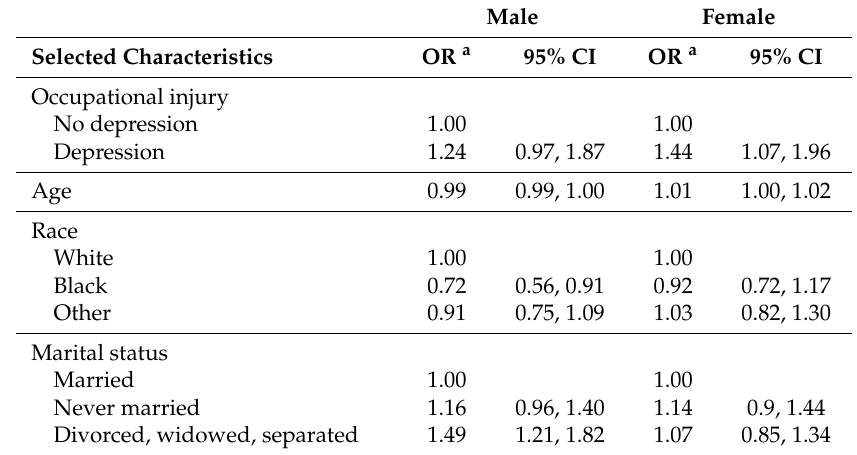
Table 5. Association between occupational injury and subsequent depression in the MEPS population. Male